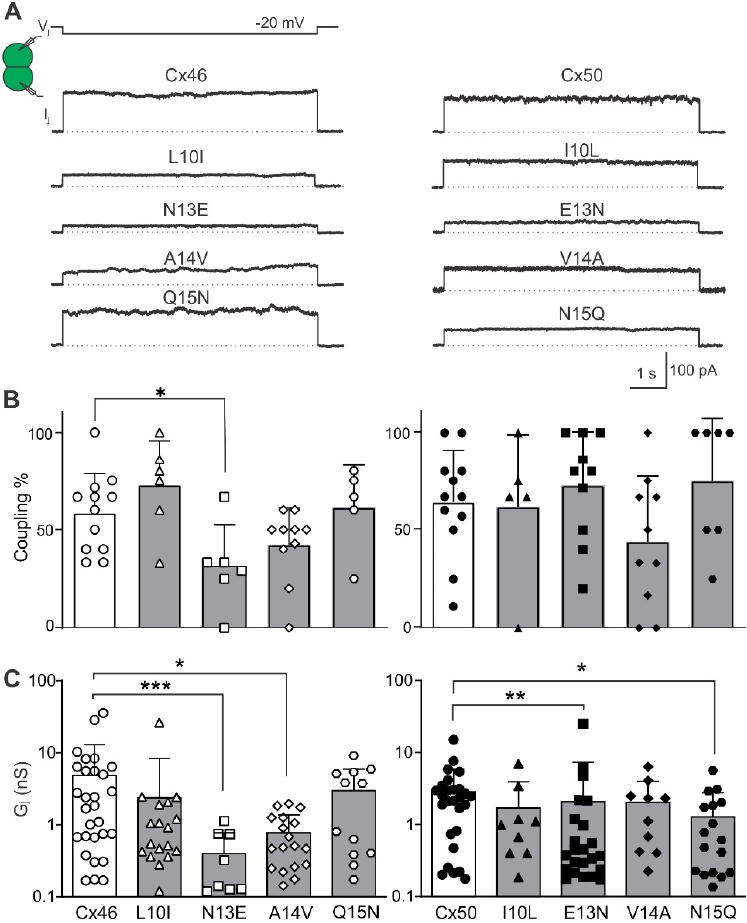
Figure 2. Coupling percentage and conductance (G j ) of N2A cell pairs expressing homotypic wild- type Cx46, Cx50, and their variants on 10th, 13th, 14th, and 15th positions in the NT domain as indicated. ( A ) A typical transjunctional current (I j ) is shown for N2A cell pairs expressing one of the designed missense variants or wild-type as indicated. Expression of each of these variants successfully led to GJ coupling with I j s recorded in response to a − 20 mV V j pulse delivered to the other cell of the pair as shown. ( B ) Bar graphs illustrate mean coupling% + SD for each of the Cx46 variants (left panel) or Cx50 variants (right panel). Each data point represents coupling% for one transfection and 3–10 successful recordings were included to calculate coupling% for each transfection. Only the Cx46 N13E variant showed a reduced coupling% compared to Cx46 (* p = 0.014) with Kruskal–Wallis test followed by Dunn’s test. ( C ) Bar graph shows averaged coupling conductance (G j ) of coupled N2A cell pairs expressing each of the variants as indicated. The error bars represent SD. Cell pairs expressing Cx46 N13E and A14V showed significantly lower G j compared to Cx46, while Cx50 E13N and N15Q displayed a significantly reduced G j compared to Cx50. Kruskal–Wallis test followed by Dunn’s test was used to compare each variant G j to the corresponding wild-type G j . Empty vector- transfected (IRES-GFP) N2A cells were used as negative controls for these experiments and none of the negative control cell pairs showed any I j s. Statistical significance is indicated with asterisks (* p < 0.05; ** p < 0.01, *** p < 0.001). Different shaped symbols in the bar graph indicate individual measurements of the corresponding variants shown at the